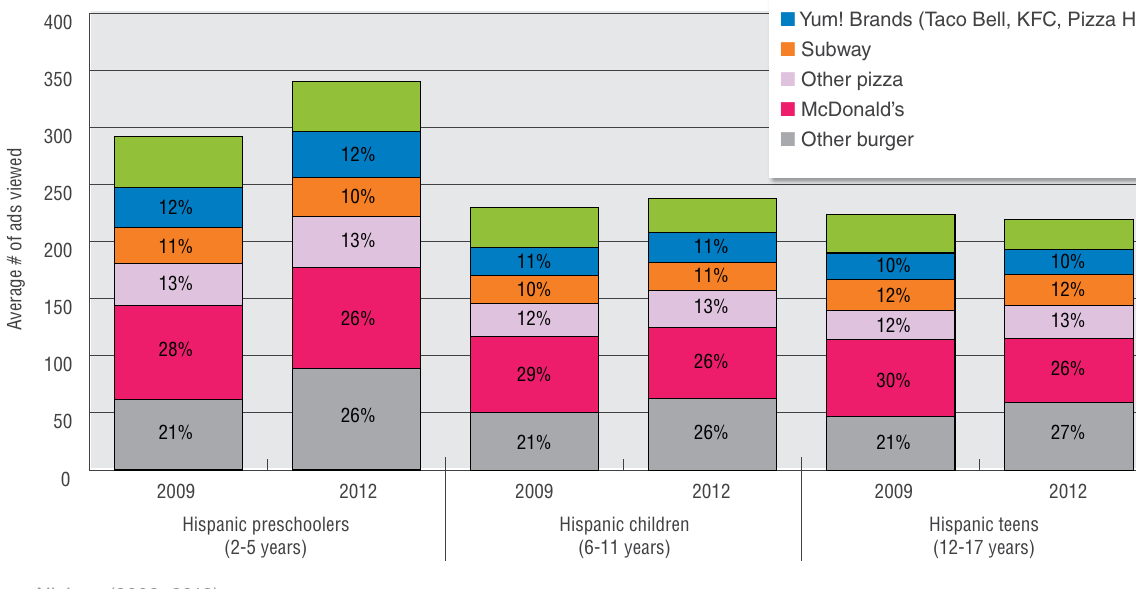
Figure 16. Average number of ads viewed on Spanish-language TV